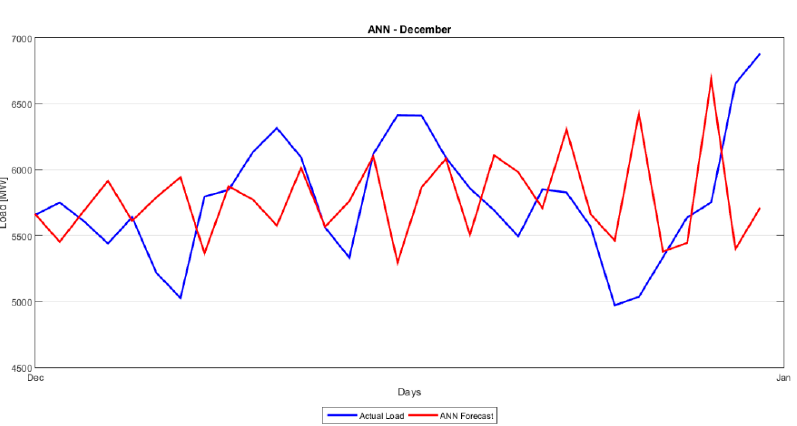
Figure 26. ANN forecast for December 2014.